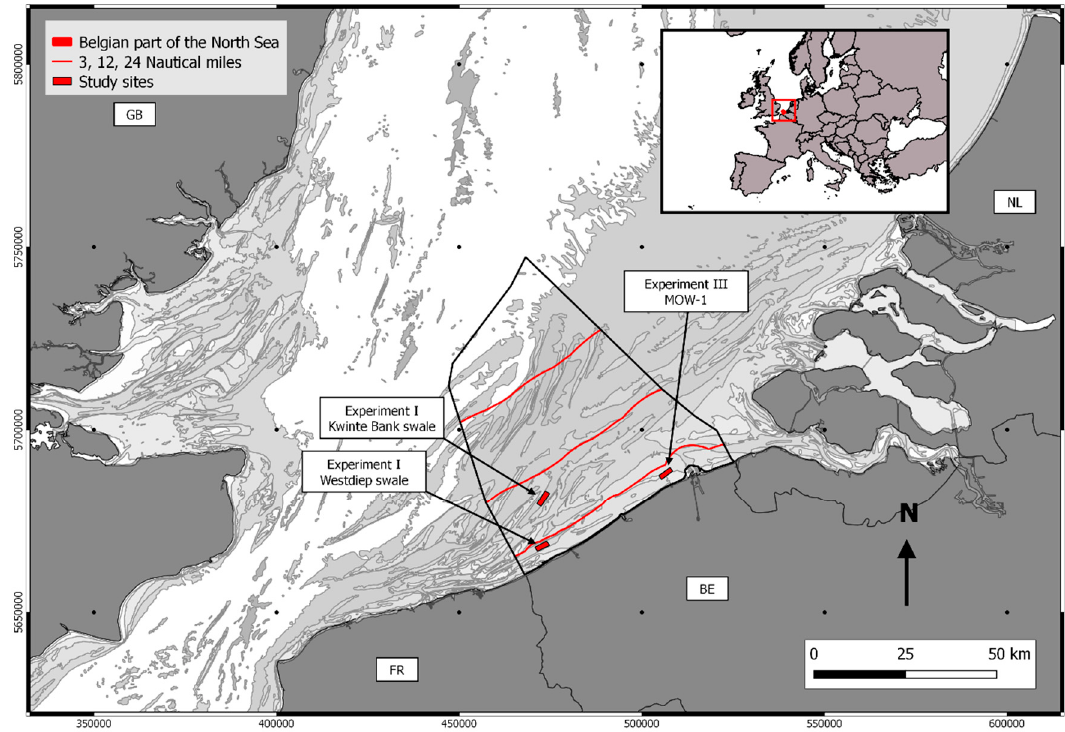
Figure 1. Location of selected study sites within the Belgian part of the North Sea: (1) Kwinte swale area (central coordinate: N 51 ◦ 17.2717, E 002 ◦ 37.7035), (2) Westdiep swale area (N 51 ◦ 09.1230, E 002 ◦ 34.6806), (3) Zeebrugge, MOW 1 pile area (N 51 ◦ 21.6697, E 003 ◦ 06.5798). The inset shows the location of the Belgian part of the North Sea within the European geographical zone. Data are projected in World Geodetic System 84 (WGS 84) in Universal Transverse Mercator Zone 31 N (UTM—31N). This coordinate system is used throughout the rest of the document. Table 2. Environmental characteristics of the three experimental areas, each having distinct seafloor substrate properties. MLLWS: Mean Lowest Low Water at Spring tide.